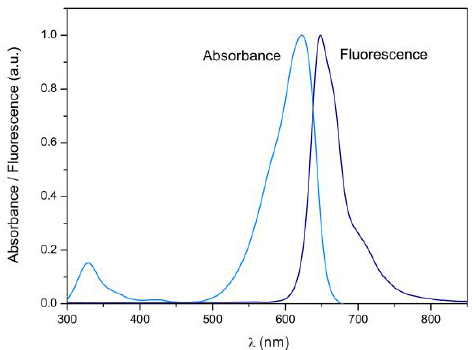
Figure 1. Measured normalized absorbance/fluorescence spectra of Oxazine 170 perchlorate in ethanol, fluorescence measured at excitation 593.5 nm. fluorescence measured at excitation 593.5